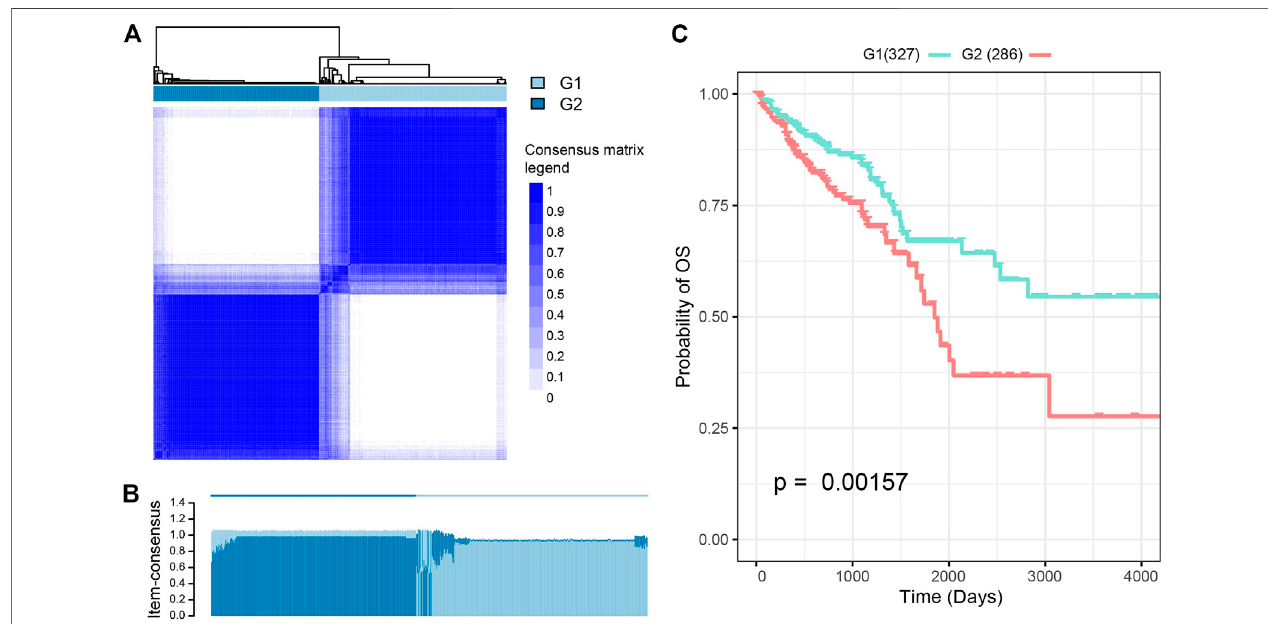
FIGURE 2 | Subtyping analysis of the Cancer Genome Atlas-colorectal cancer (TCGA-CRC) patients. (A) K-means clustering analysis split these patients into two subgroups. The optimal number of clusters was determined using three parameters: The C index for prognostic differences, the Silhouette index, and the Calinski – Harabasz criterion. (B) Performance ofK-means clustering when k was set at 2. (C) There were signi fi cantdifferences in survivalratesbetween these twoCRC subtypes.